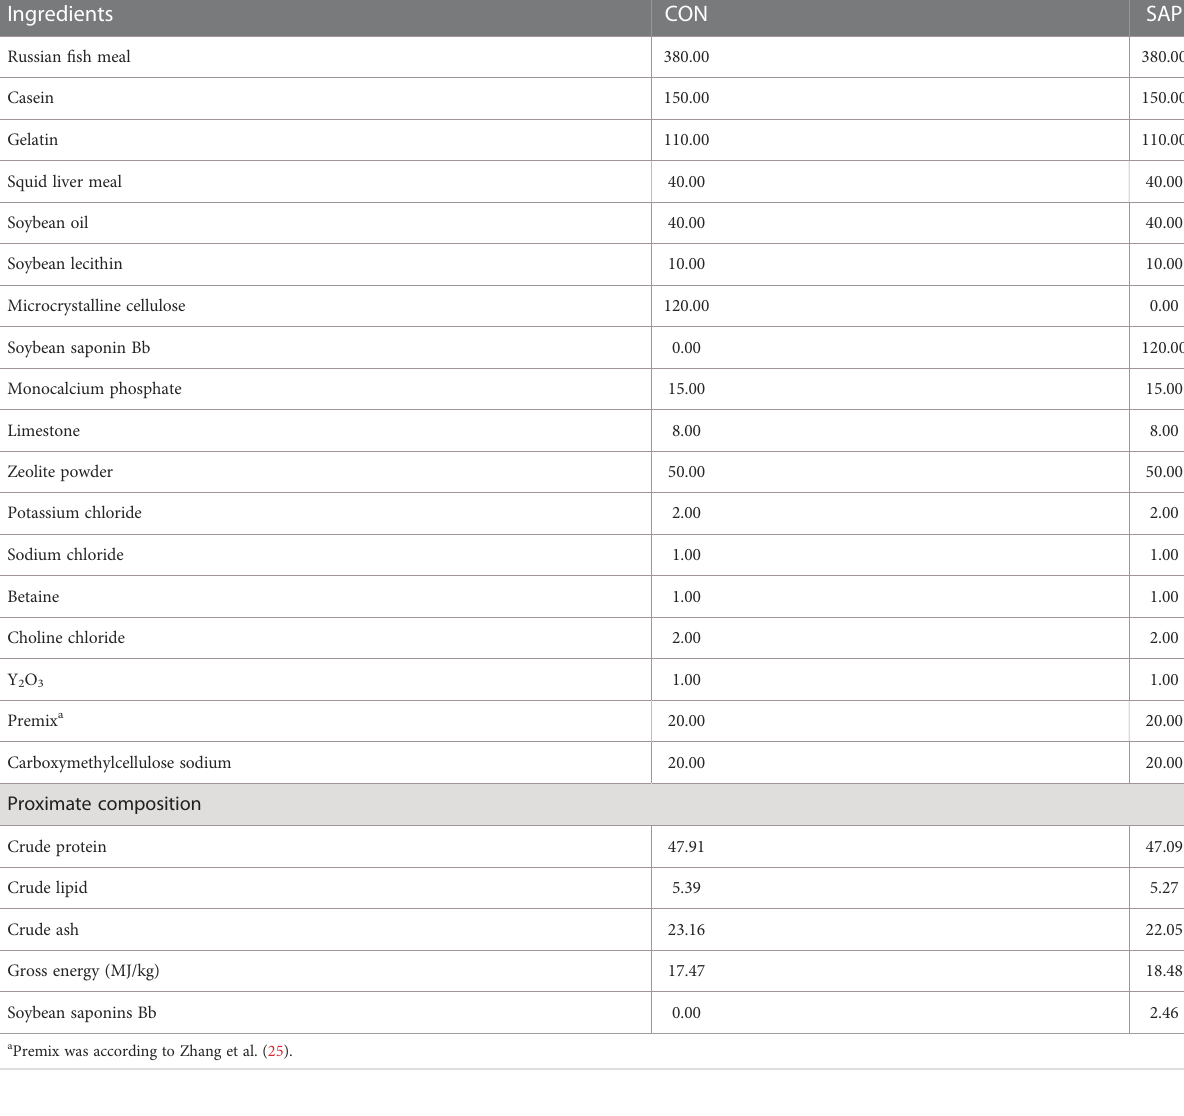
TABLE 1 Diet formulation and proximate chemical composition of the experimental diets (dry matter basis, g/kg).